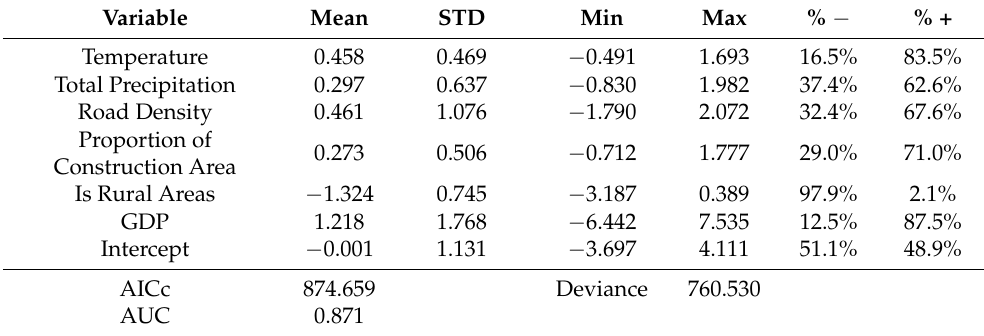
Table 4. Summary statistics for geographically weighted logistic regression parameter